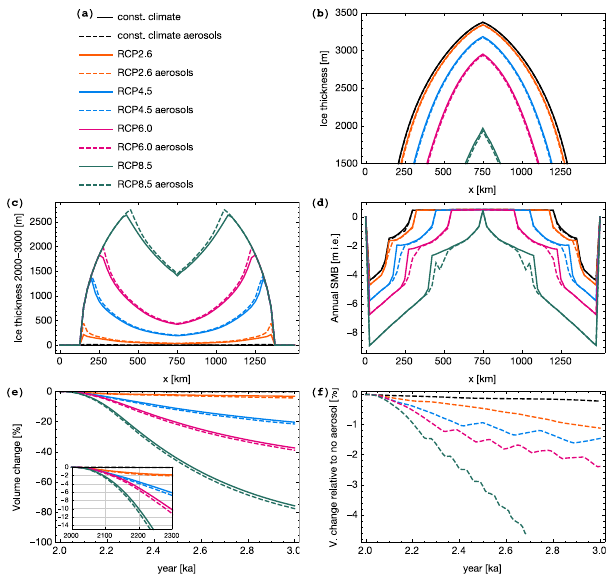
Figure 7. Results of the simulations driven by the representative concentration pathways: (a) common curve styles, (b) ice thickness in the year 3000, (c) elevation difference compared to the constant climate run, (d) SMB in the year 3000, (e) relative volume change compared to the constant climate/no-aerosols scenario (inset: de- tailed plot for the period until 2300) and (f) volume change due to the inclusion of aerosols.